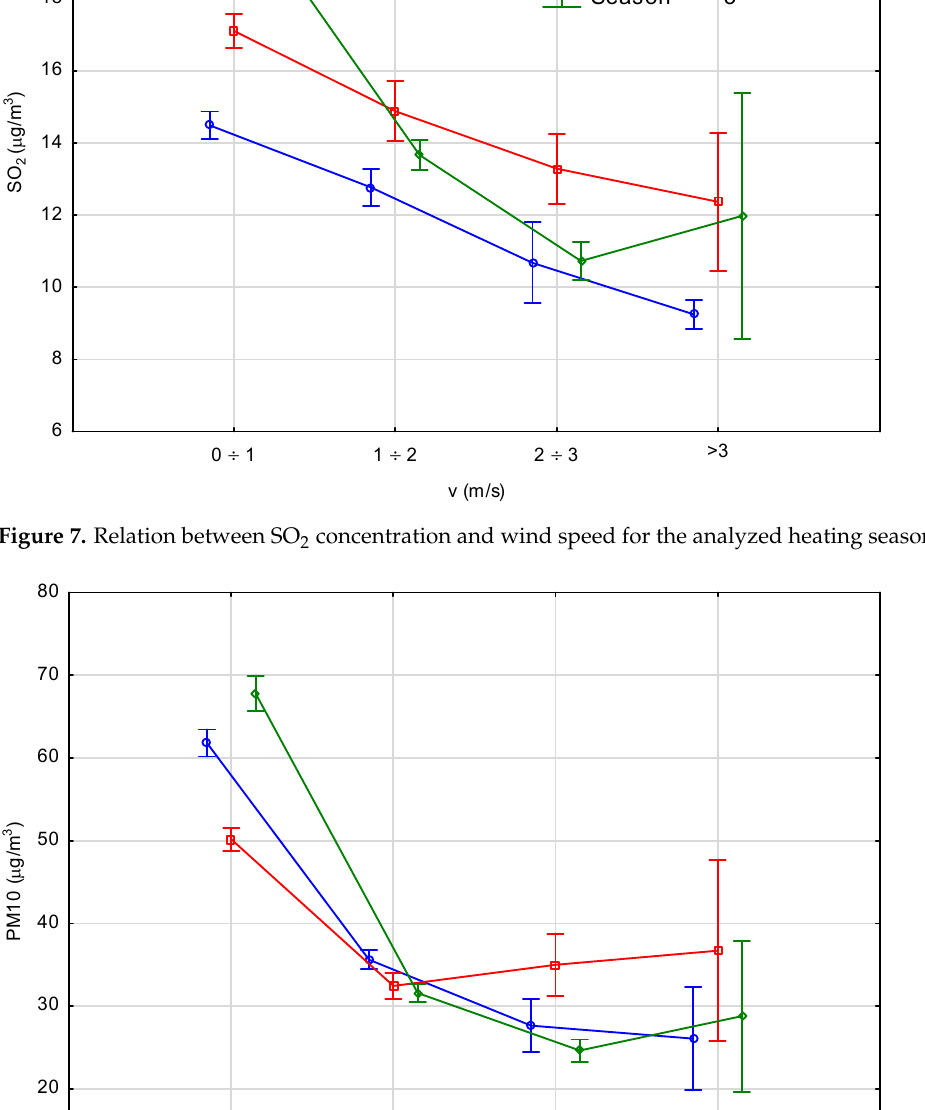
Figure 8. Relation between PM 10 concentration and wind speed for the analyzed heating seasons.